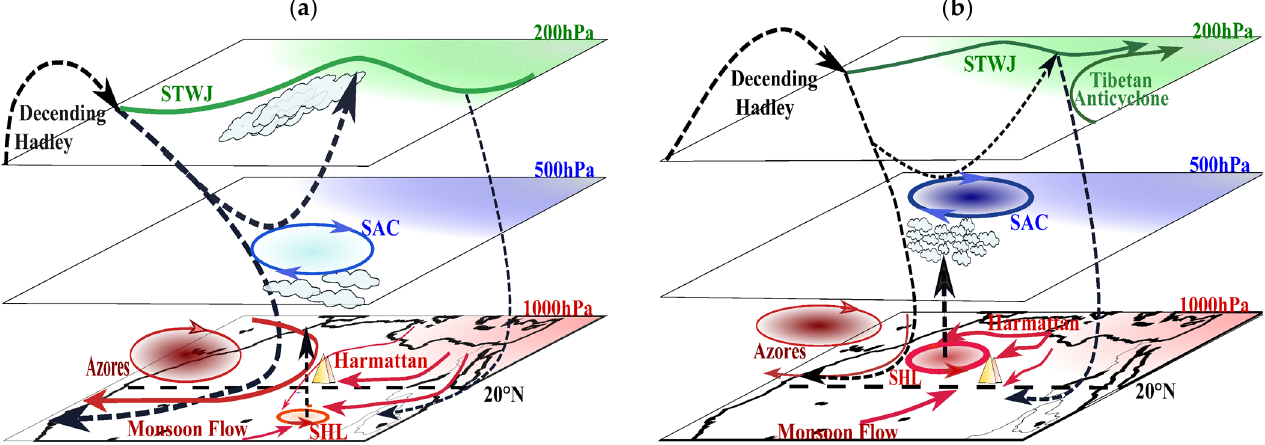
Figure 16. Circulation over West Africa during ( a ) Spring and ( b ) Summer, when the SHL (thick red circle) settles over the northern edge of West-Sahara. At low levels, the SHL and Azores anticyclone (thick and thin red circles with arrows, respectively), the Harmattan wind (north-south oriented red arrow), the Atlantic inflow (red arrow around the Azores anticyclone) and the monsoon flow (south-north oriented red arrow). In the mid-troposphere is the Saharan anticyclone (blue circle with arrows). In the upper troposphere are the sub-tropical westerly jet (STWJ in green) and the Tibetan anticyclone (green arrow). The vertical circulation between the three levels is highlighted as dashed black arrows (descending branch of the Hadley cell, descent of a Rossby wave over the Mediterranean, ascendance in the SHL). For the SHL and the SAC and Azores anticyclone, strengthening of the intensity is indicated by an increase in brightness color. Increasing thickness of arrows indicate an increase in the strength of the circulation. The Hoggar position is indicated by the two triangles. The location of mid-level clouds is also indicated.